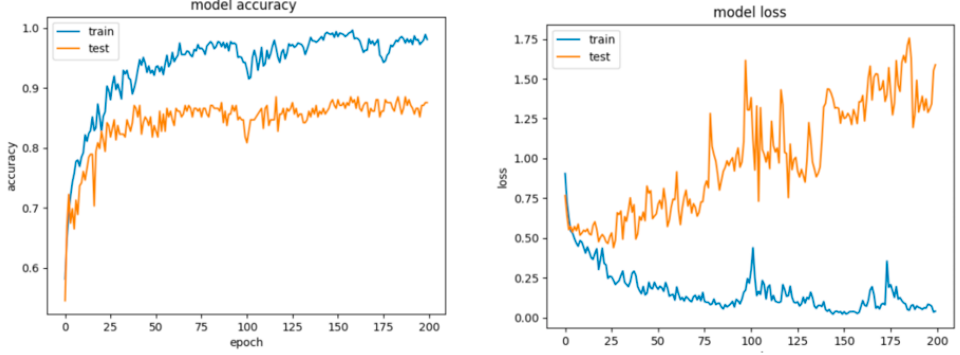
Figure 18. Accuracy and loss for Configuration 1, non-overlapping dataset.